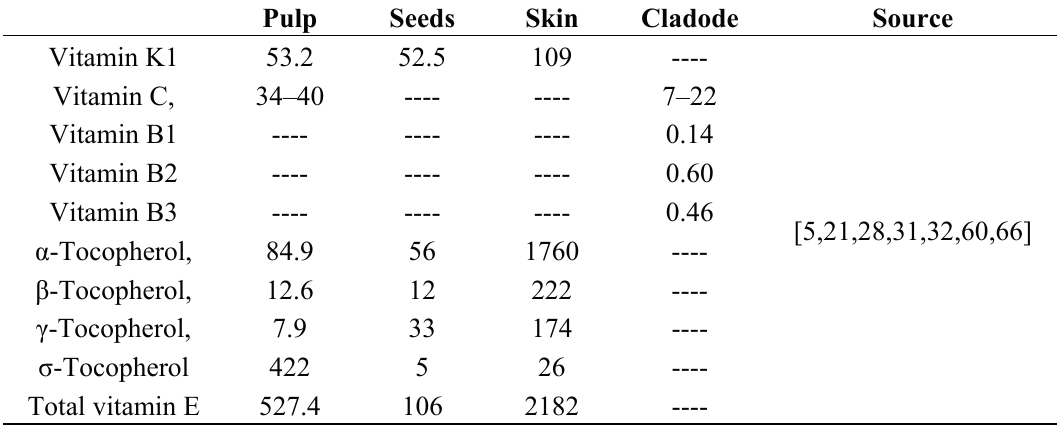
Table 3. Distribution and contents of vitamins in the different parts of fruit and cladode from prickly pear of O. ficus-indica. Vitamin contents are expressed as mg/100 g tissue. Pulp Seeds Skin Cladode Source Vitamin K1 53.2 Vitamin C, 34–40